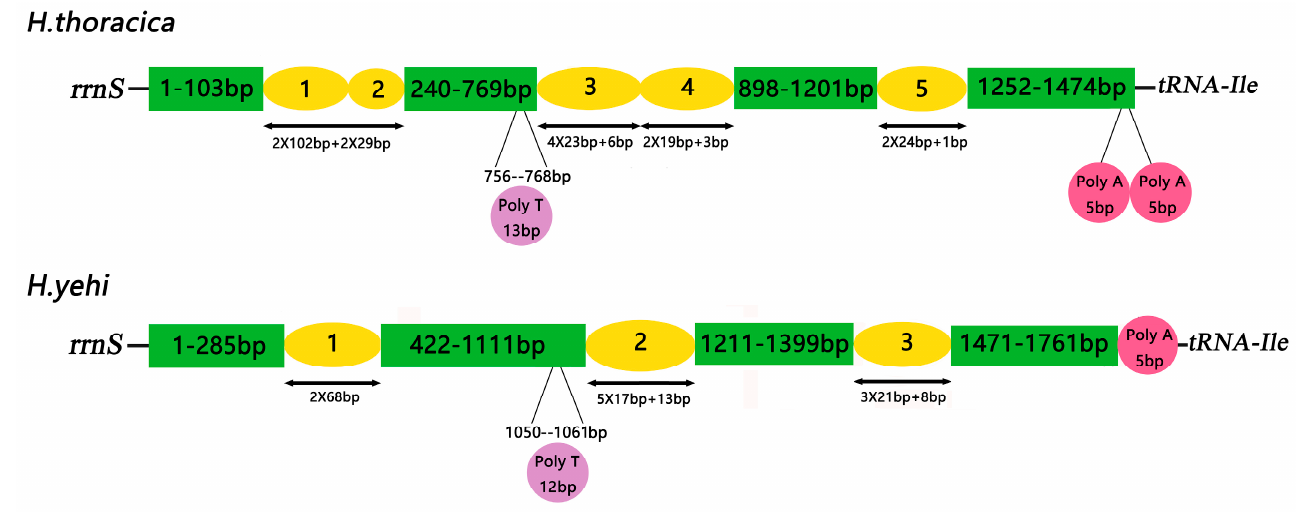
Figure 8. Organization of the control region in Helota mt genomes. The yellow ovals (number 1,2,3 ... ) indicate the number of tandem repeats, the numbers below mean the sequence length (bp) of tandem repeats; the purple and red rounds indicate the Poly T/A; the non-repeat regions are shown with green boxes.